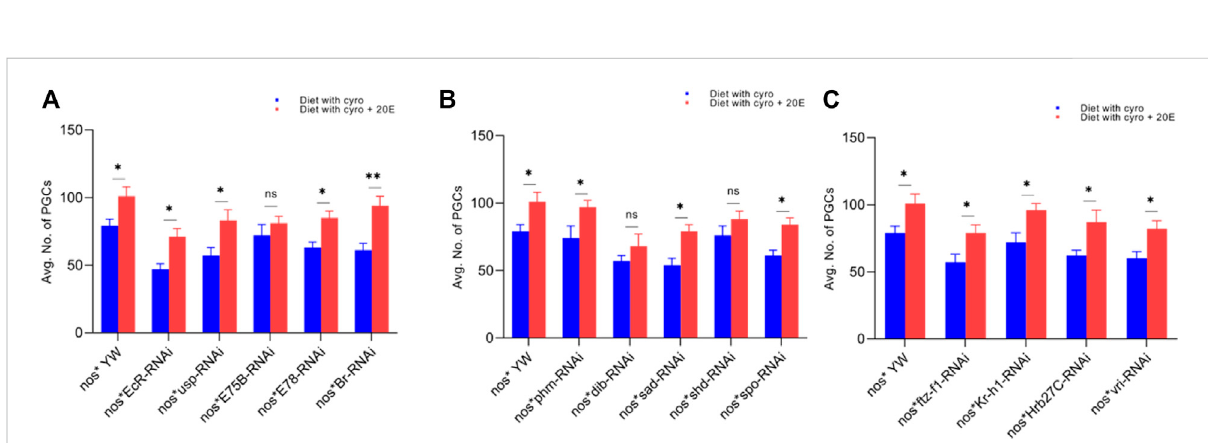
FIGURE 5 Rescue experimentof PGCs. (A) The number of PGCs against ecdysone-responsive primary genes. (B) The number ofPGCs against Halloween genes. (C) The numbers PGCs against ecdysone-responsive genes. The blue bars indicate the numbers of PGCs against the cyromazine